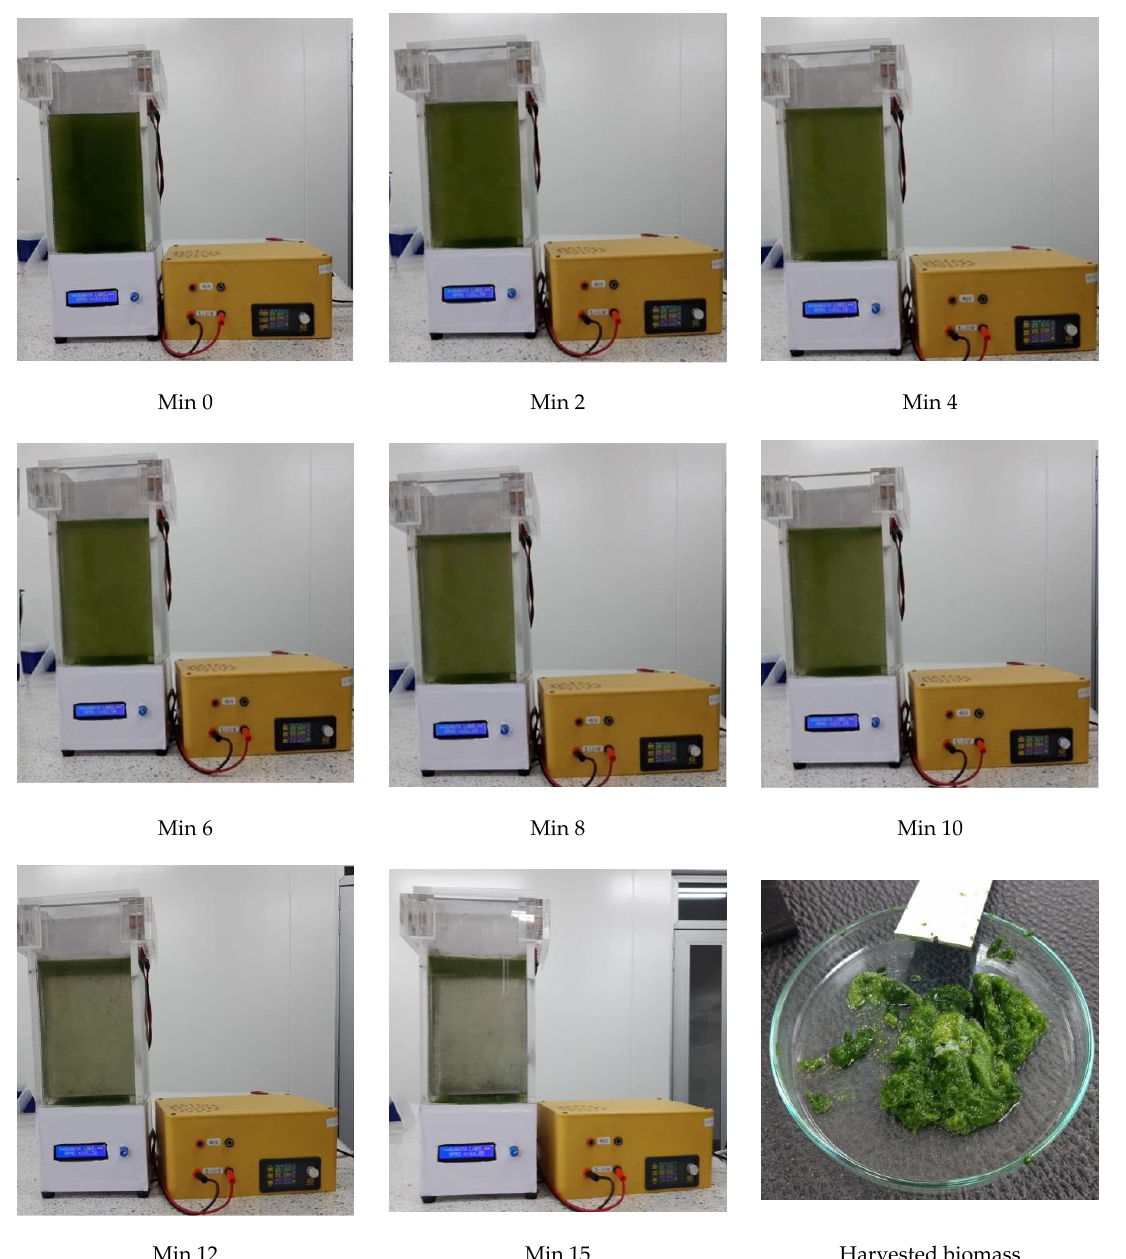
Figure 3. The concentration of biomass using the new equipment for electroflotation.